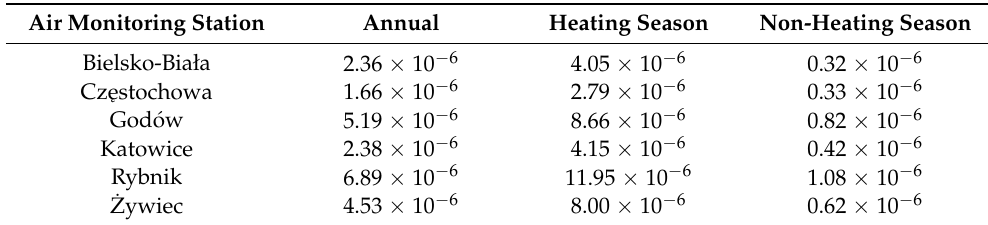
Table 5. Descriptive data on lifetime cancer risk (LCR) from the inhalation exposure to PM10-bound B[a]P in ambient air according to IRIS